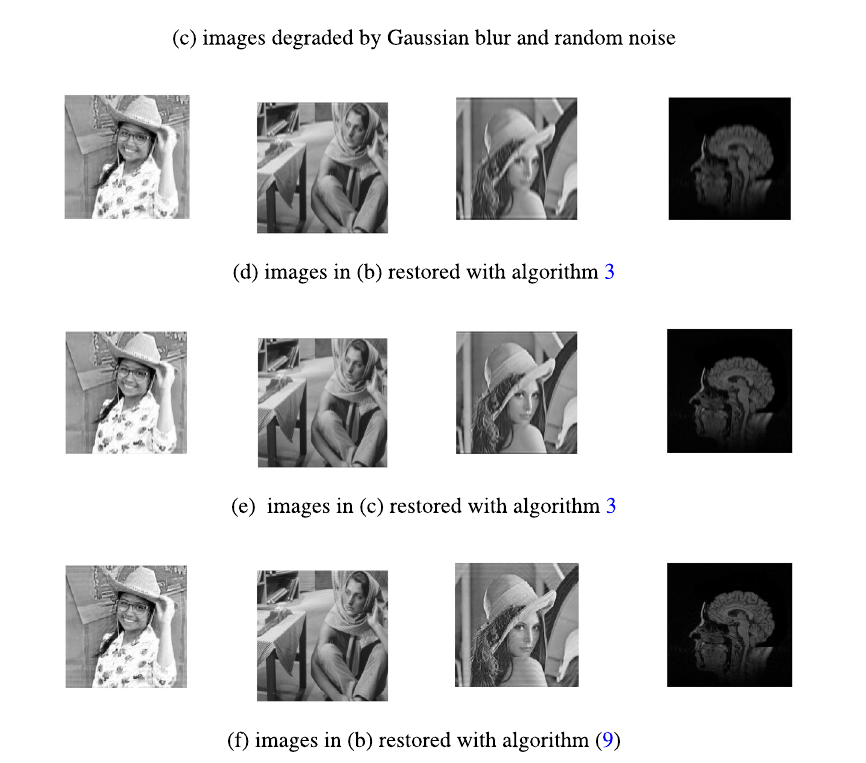
Figure 1 Degradation of the test images and their restorations via Algorithms (3) and (9)